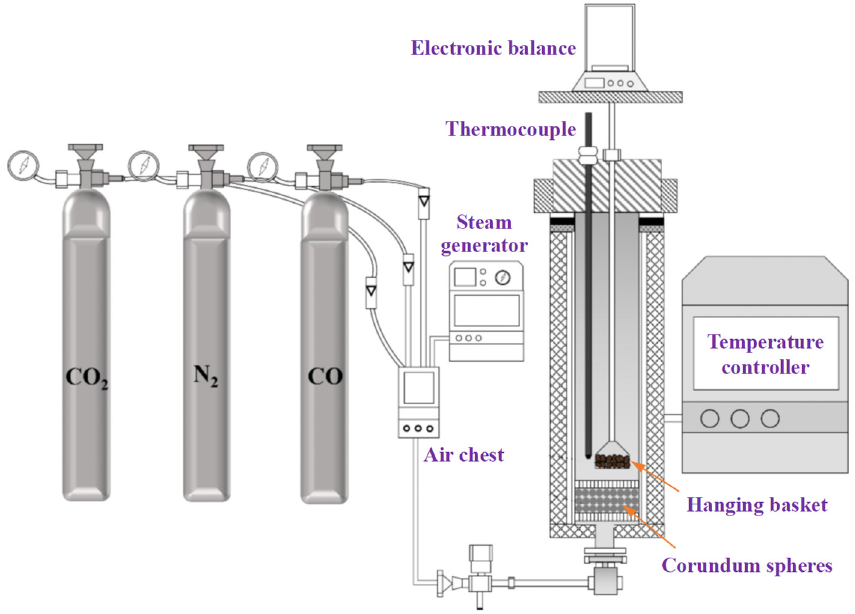
Figure 1. Schematic diagram of a comprehensive tester for coke metallurgical properties.